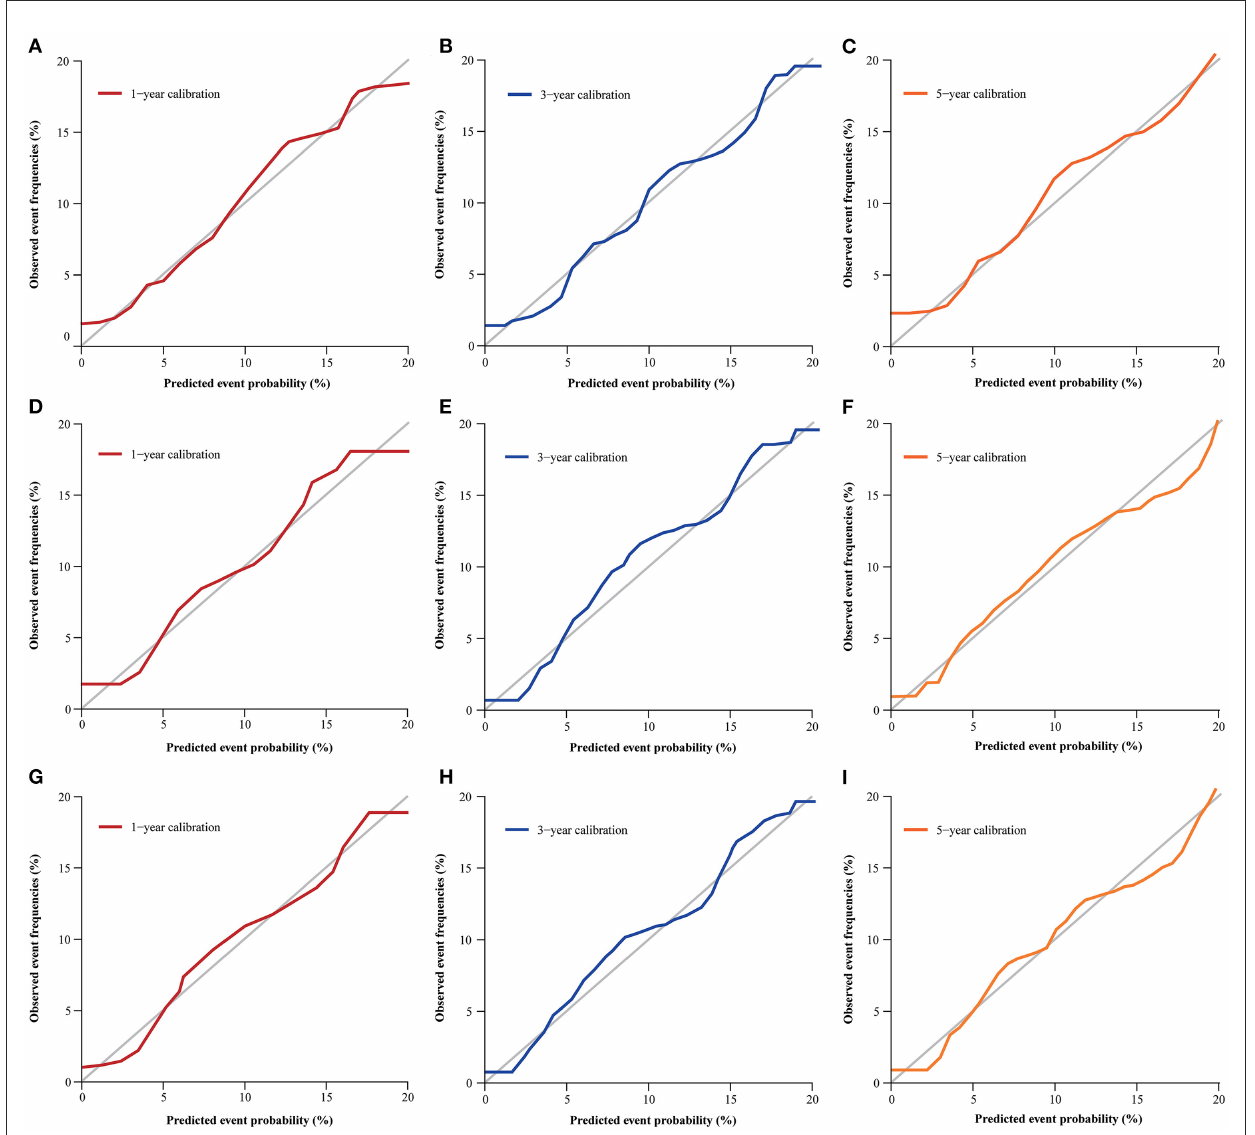
FIGURE4 Calibration curve for predicting MACE probability at 1- (A) , 3- (B) , and 5-year (C) in the derivation cohort; 1- (D) , 3- (E) , and 5-year (F) in validation cohort; 1- (G) , 3- (H) , and 5-year (I) in the full